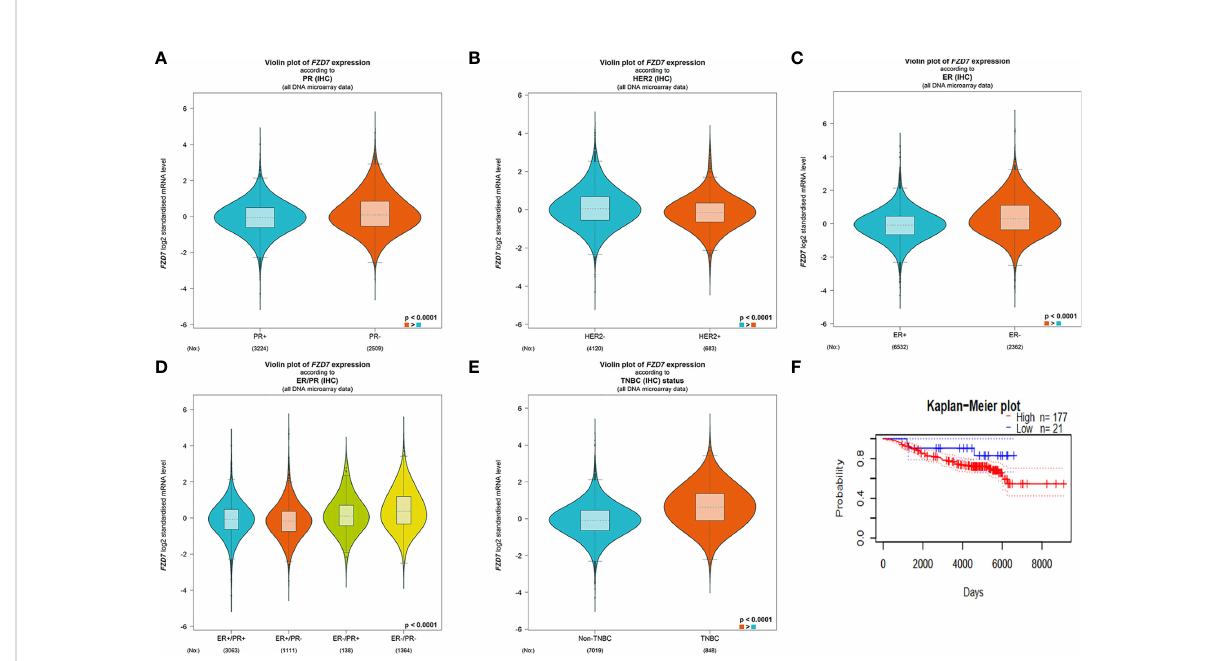
FIGURE 1 BC-GenexMiner V4.3 and PrognoScan: Boxplot assessment of FZD7 gene expression and survival analysis based on clinical parameters of breast cancer patients. (A) PR. (B) HER-2. (C) ER. (D) ER/PR. (E) triple-negative status. (F) overall